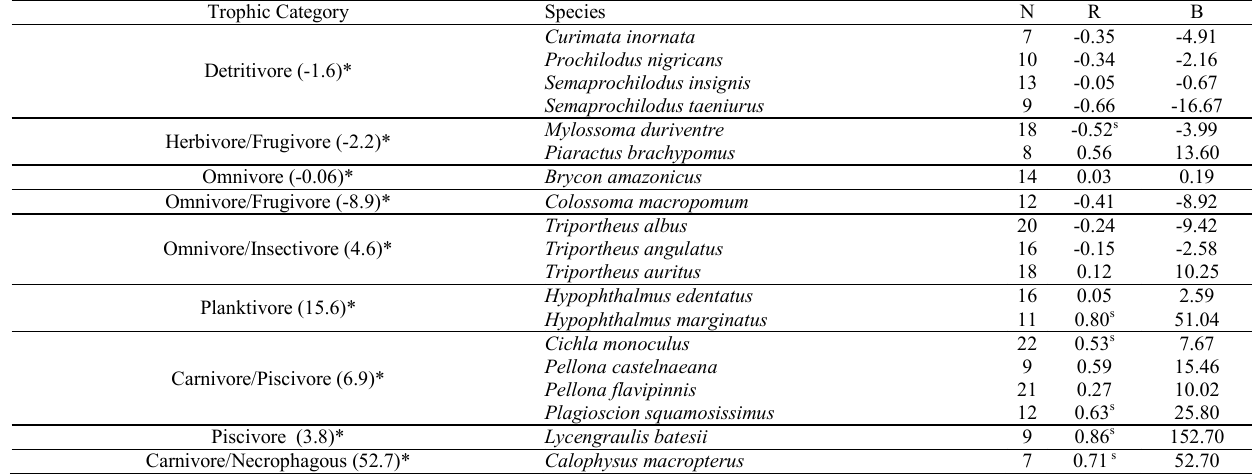
Table 2. Bioaccumulation rate (B) and correlation coefficient (R) of total mercury total (ng.g -1 ) vs . standard length (cm) of fish from Lago Grande de Manacapuru. S P<0.001. *Bioaccumulation rate for the trophic